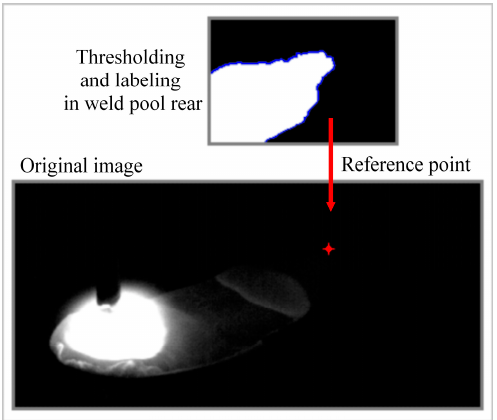
Figure 6. Reference point located for a typical acquired frame and the weld pool rear thresholding and labeling